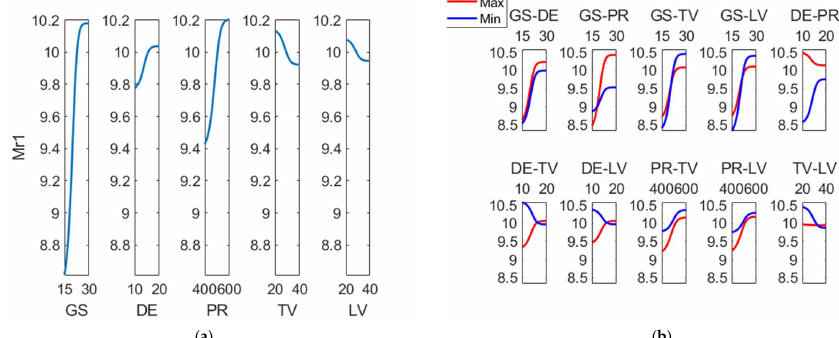
Figure 12. ( a ) Main effects plot and ( b ) interaction effects plot for Mr1 (%).